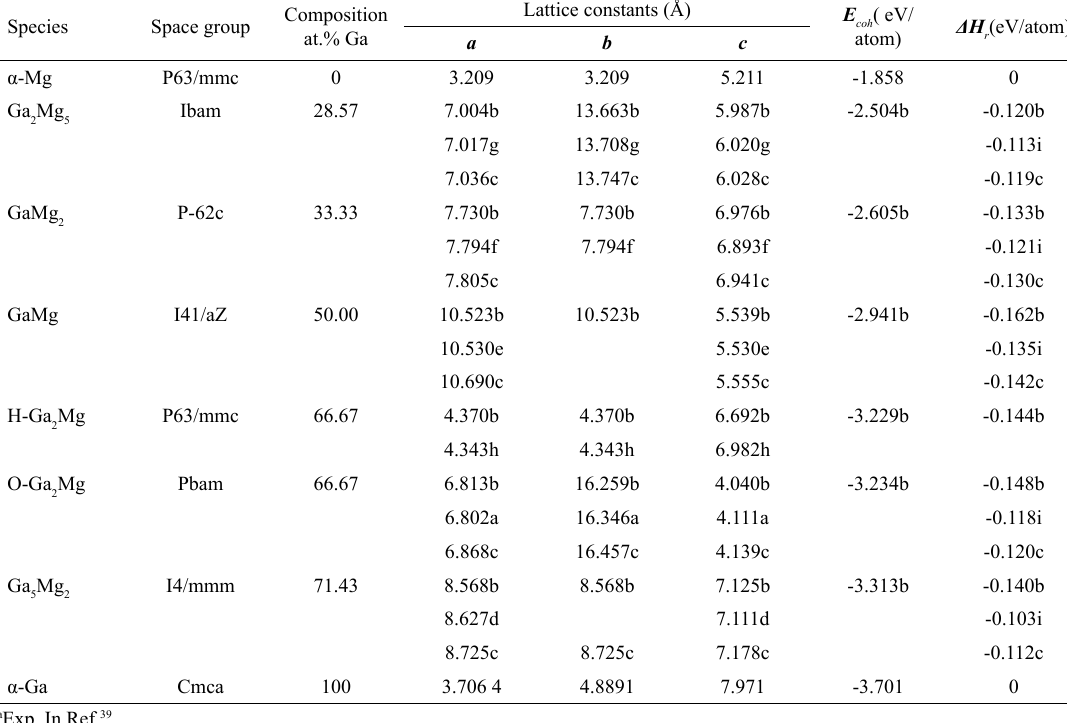
Mg ; (e) H-Ga Mg; (f) O-Ga 5 2 2 ) of Ga-Mg binary compounds. r